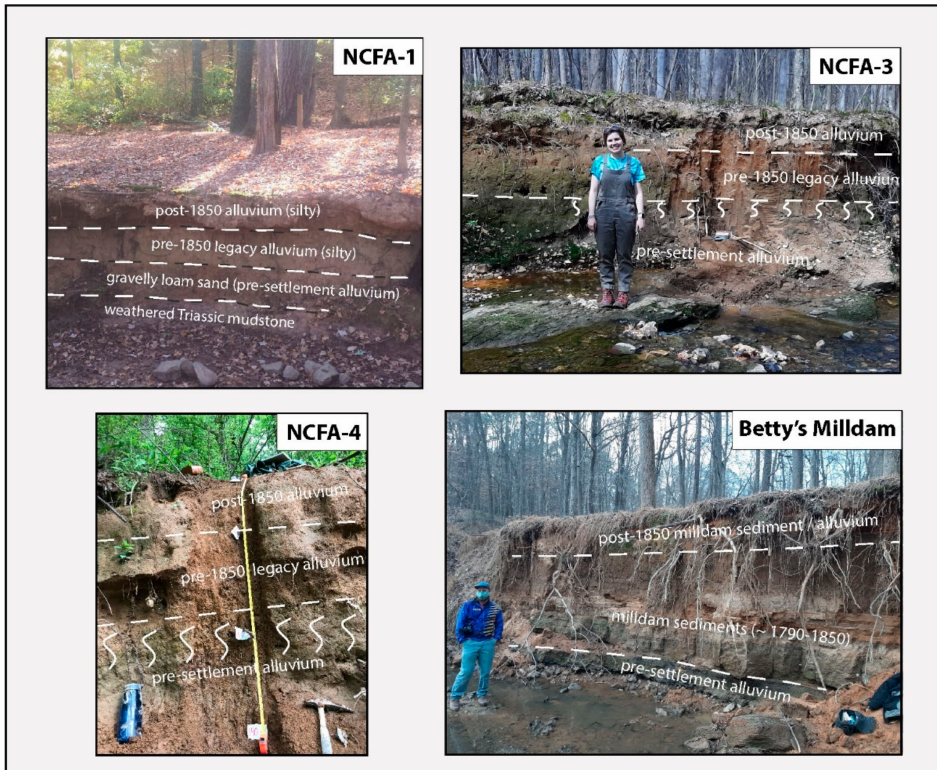
Figure 3. Photographs of four of the nine sample sites of alluvium and millpond sediment in the North Carolina Piedmont. Site NCFA-1 is located in the Triassic Basin, site NCFA-3 and NCFA-4 are in the Carolina and Raleigh area crystalline terranes, and Betty’s Milldam is a former milldam site in Umstead Park (Raleigh area terrane). A weak paleosol is observed in the top of pre-European settlement deposits at NCFA-3 and